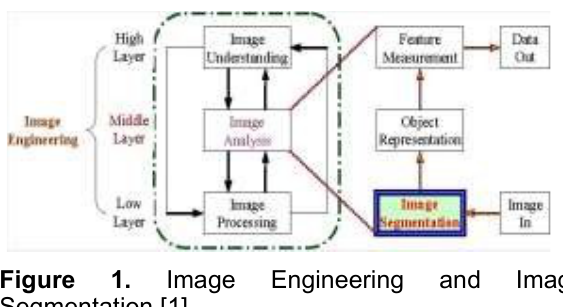
Figure 1. Image Engineering and Image Segmentation